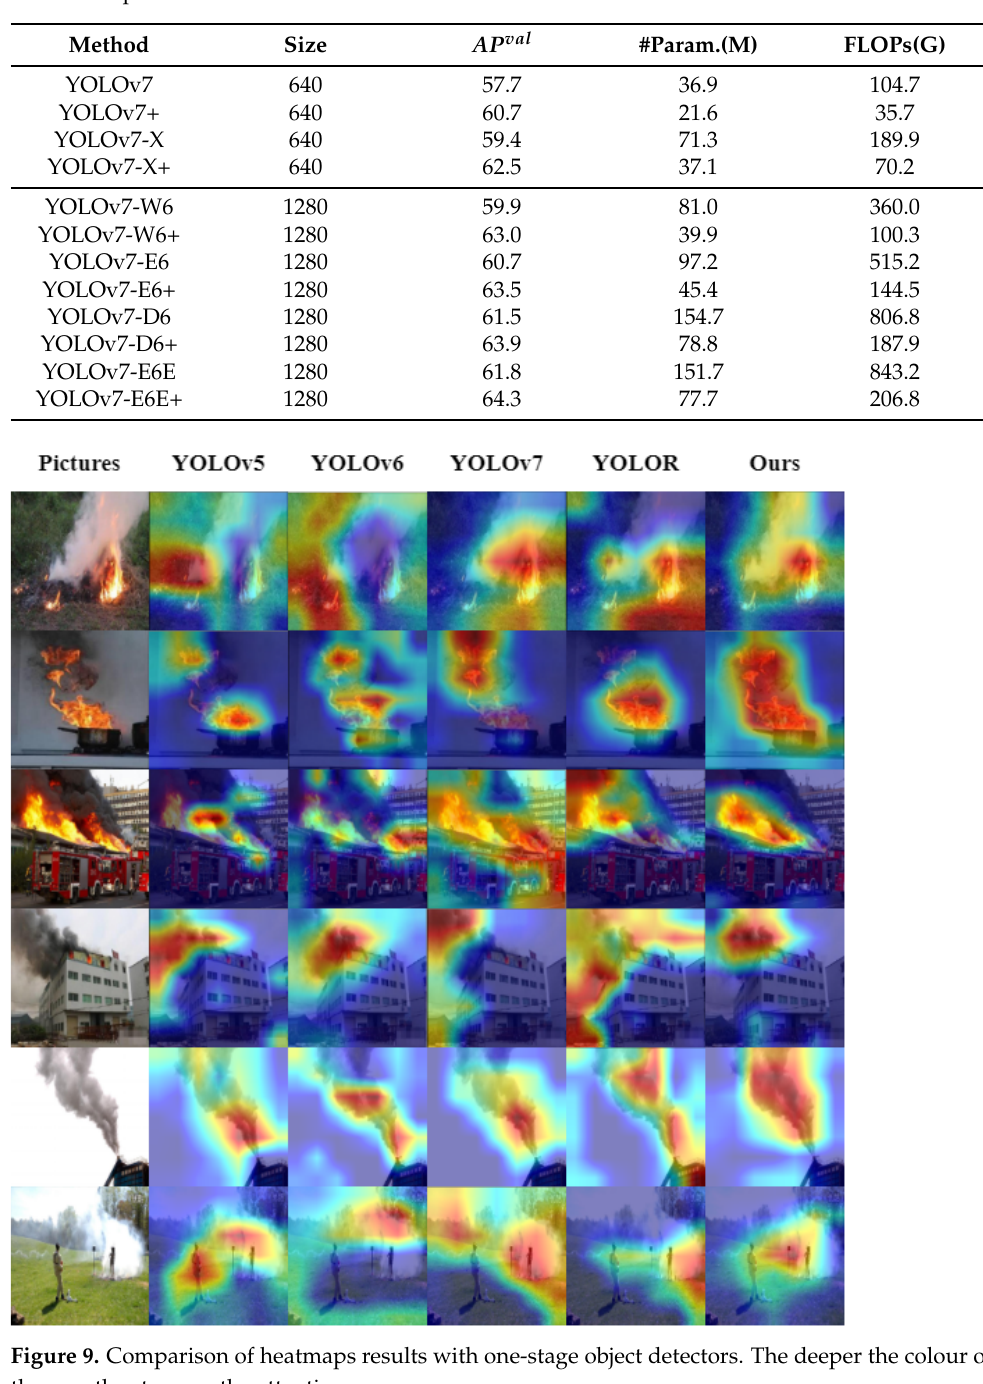
Table 6. Improved results for different detection scales for YOLOv7 variants.